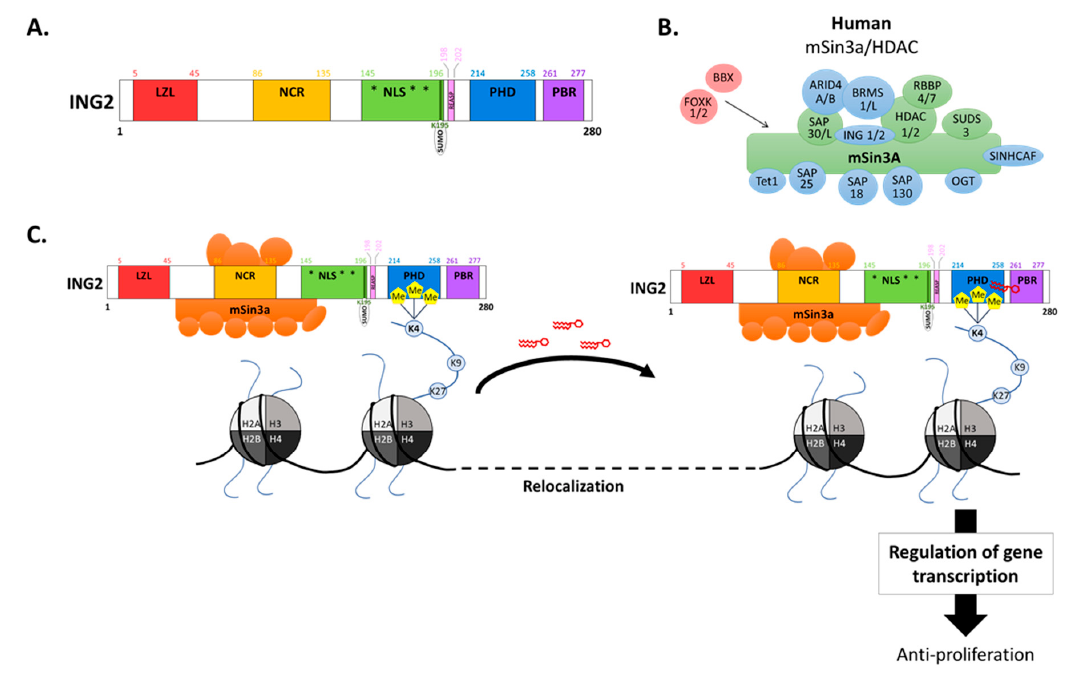
Figure 1. ING2 regulation of gene transcription through its interaction with H3K4me3 and the transcriptional regulator complex mSin3A / HDAC. ( A ) Protein structure of Human ING2. LZL—leucine zipper-like region; NCR—novel conserved region; NLS—nuclear localization signal, *within the NLS three short regions act as a nucleolar targeting signal (NTS); REASP — binding motif; PHD — plant homeodomain; PBR — polybasic region. ING2 structure was built according to UniProtKB ING2_Human (Q9H160). ( B ) Mammalian Sin3A/HDAC complex members. The core Sin3A subunits are depicted in green, the Sin3A associated proteins are depicted in blue, and the transcription factors are depicted in red. The names given for each complex member is the one approved by the HUGO Gene Nomenclature Committee (HGNC). ( C ) Schematic representation of ING2/H3K4me3/Sin3A formation regulating gene transcription. ING2 PHD domain recognizes trimethylated H3K4 (H3K4me3) as well as phosphatidylinositol 5-phosphate (PI(5)P) while the ING2 N-terminal part is